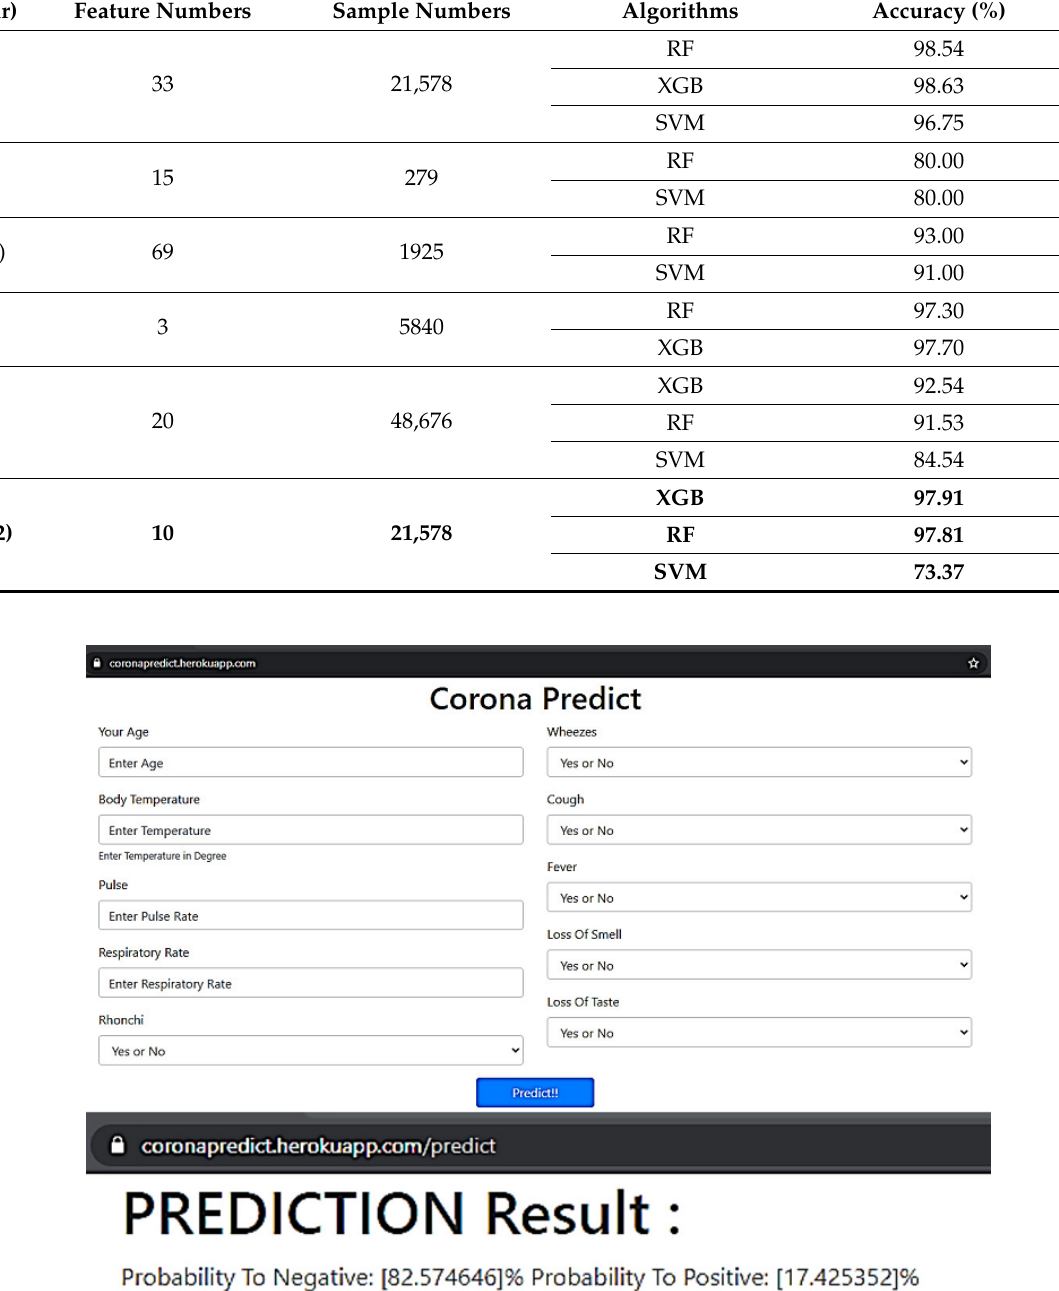
Figure 10. Screenshot of the designed web application for COVID-19 prognostication, deploying the proposed